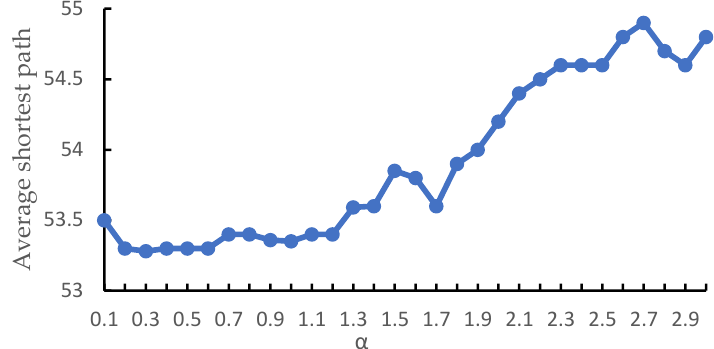
Figure 9. The effect of 𝛂 on experimental results.